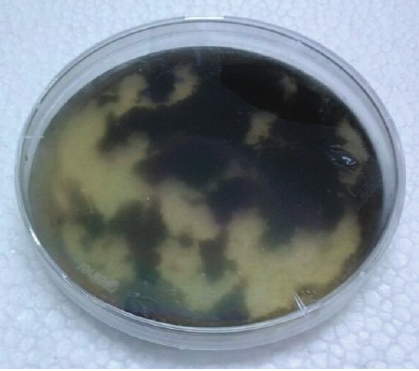
Figure 2: Colony of Sg. Ular SRB grown on agar after 7 days of incubation at 37 ∘ C anaerobiclly.